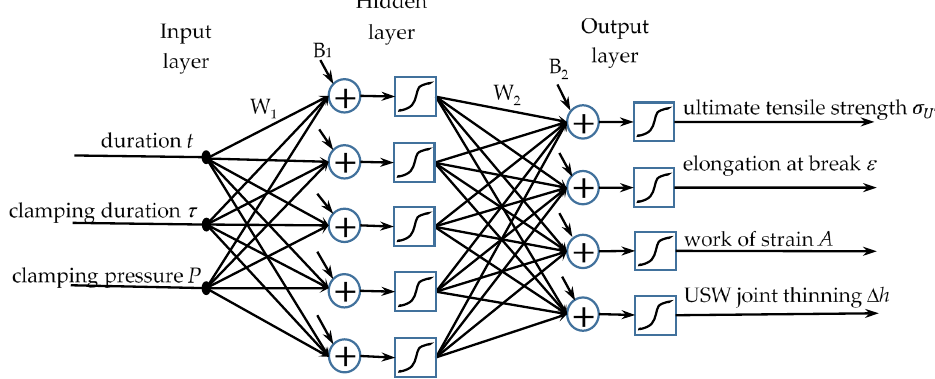
Figure 3. Architecture of artificial neural network (model 2). W—matrices of synaptic weights, B—vectors of bias weights.